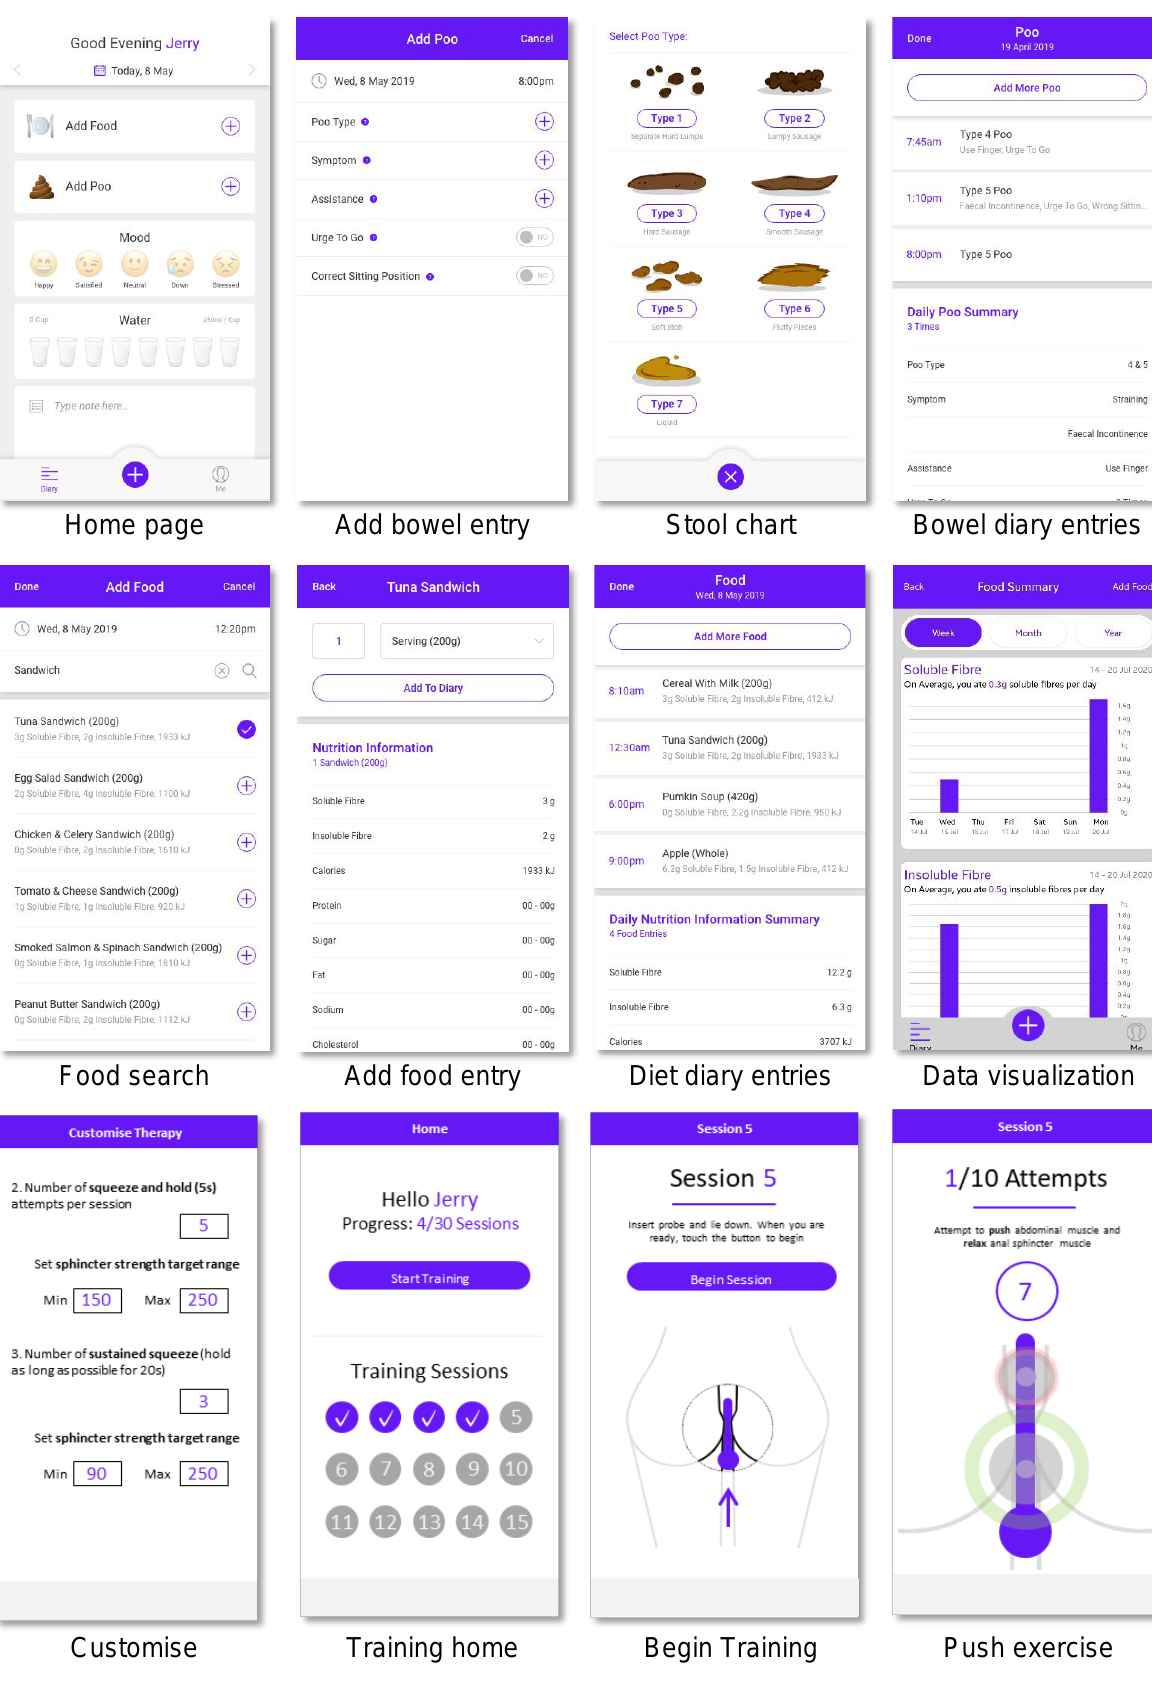
Figure 6. Examples of the mobile app’s user interface